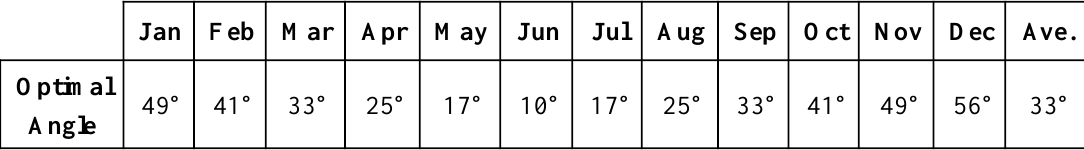
Table 1: Optimum tilt angle of PV Panel for each month at Baghdad location